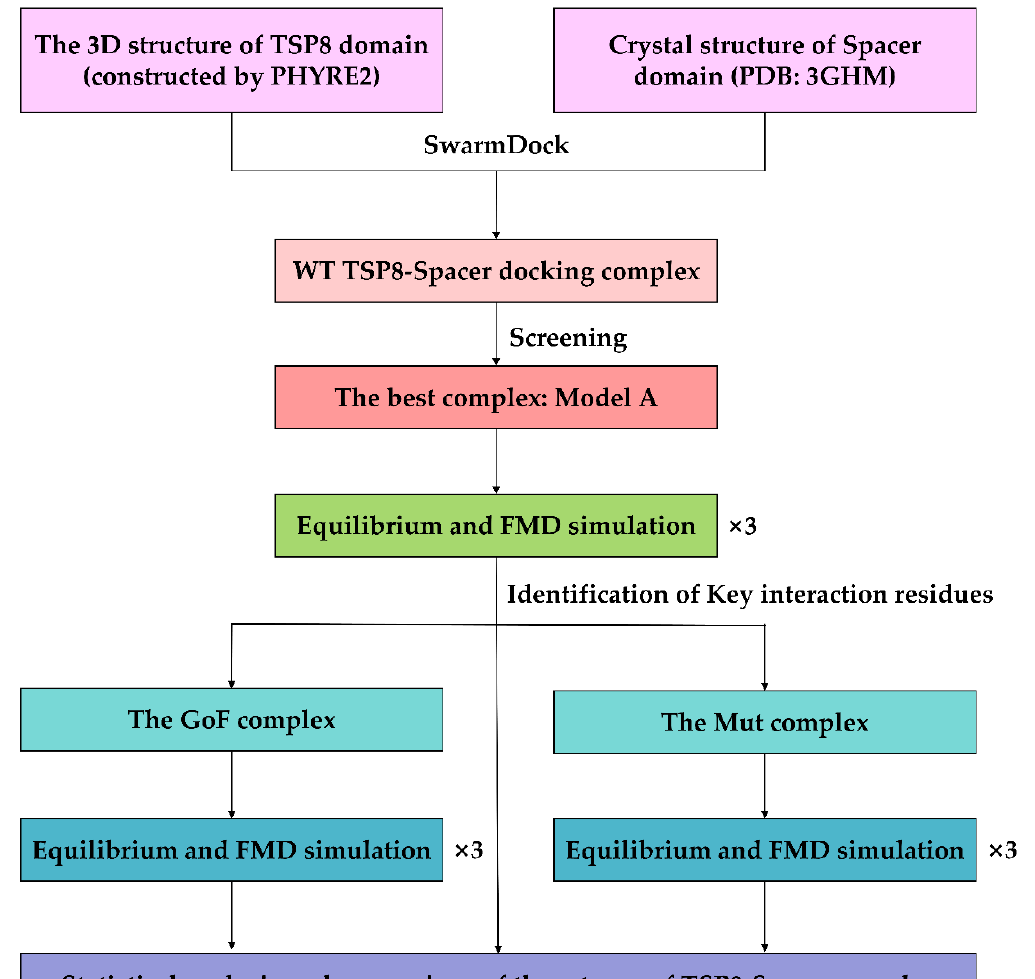
Figure 8. Workflow diagram of the simulation process.